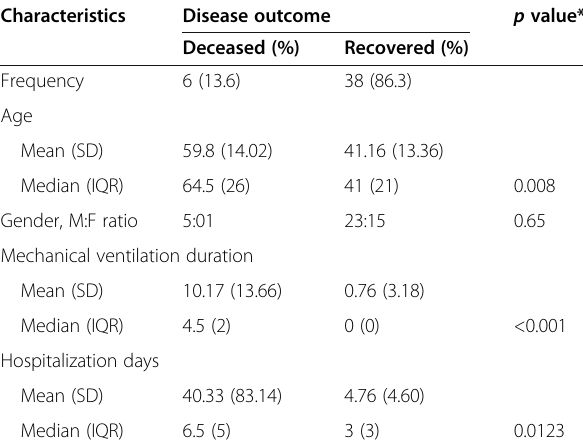
Table 1 Demographic and clinical characteristics of MERS-Cov cases by final outcome (n = 44)